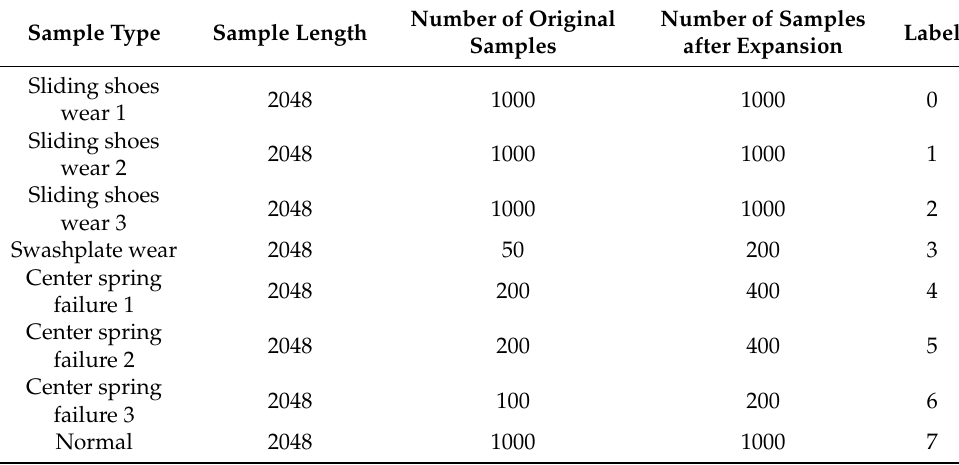
Table 11. Sample composition in two